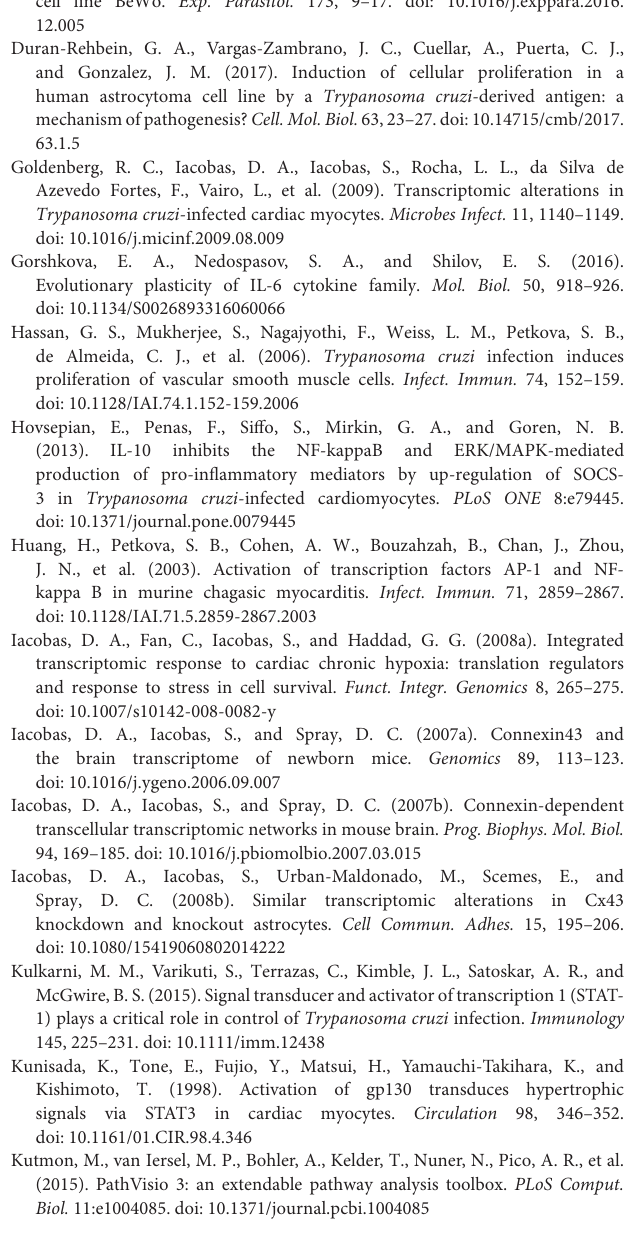
Supplementary Figure 1 | Examples of genes synergistically ( Antxr1 = ANTXR cell adhesion molecule 1), antagonistically ( Dus3l = dihydrouridine synthase 3-like), and independently ( Golim4 = golgi integral membrane protein 4) expressed genes with Clcf1 (cardiotrophin-like cytokine factor 1) in control L6E9 rat myoblasts. Numbers in brackets are the Pearson correlation